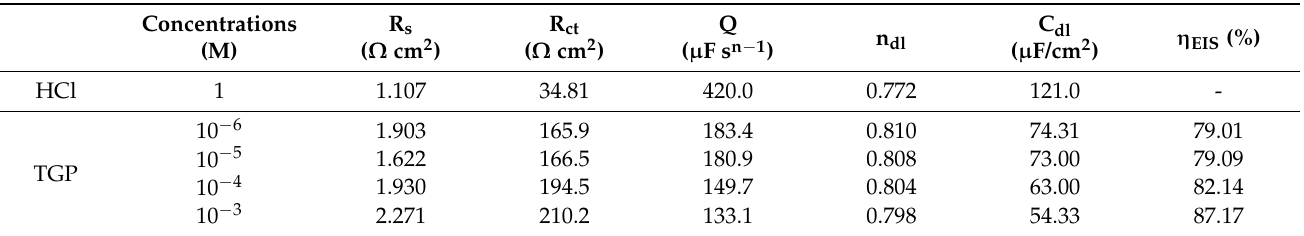
Table 2. EIS parameters for MS plunged in 1 M HCl solution, both unprotected and protected by varying concentrations of TGP.